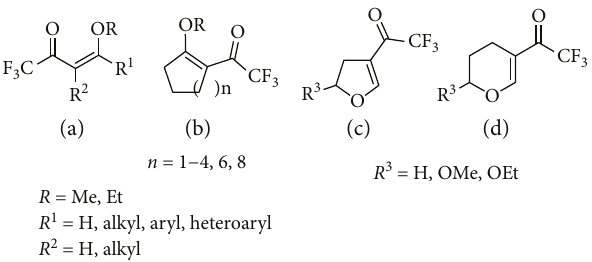
Figure 1: β -Alkoxy- α , β -unsaturated tri fl uoromethyl ketones or β -alkoxyvinyl tri fl uoromethyl